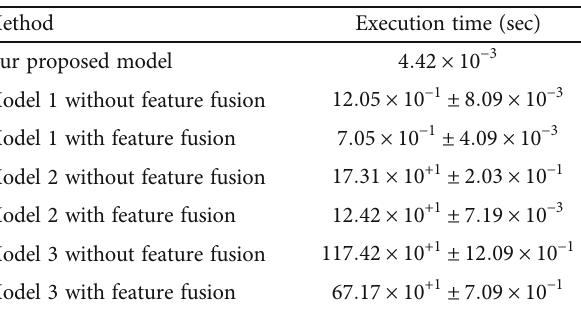
Table 9: Comparison of the prediction time in seconds with the same training dataset.